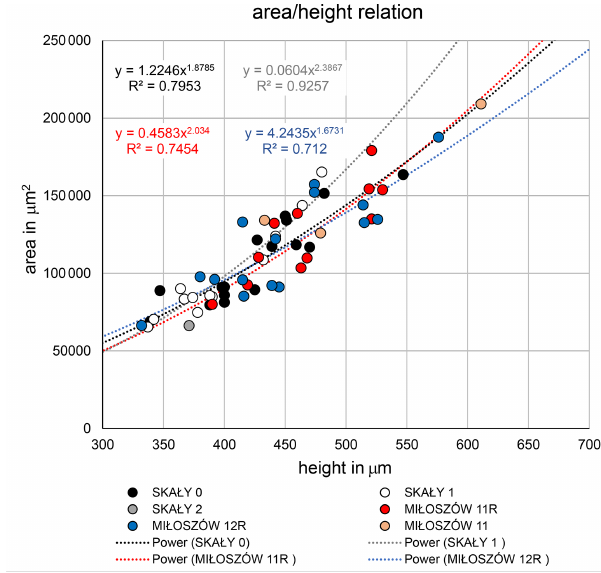
Figure 3. Relationships between test area and test height fitted by power functions.